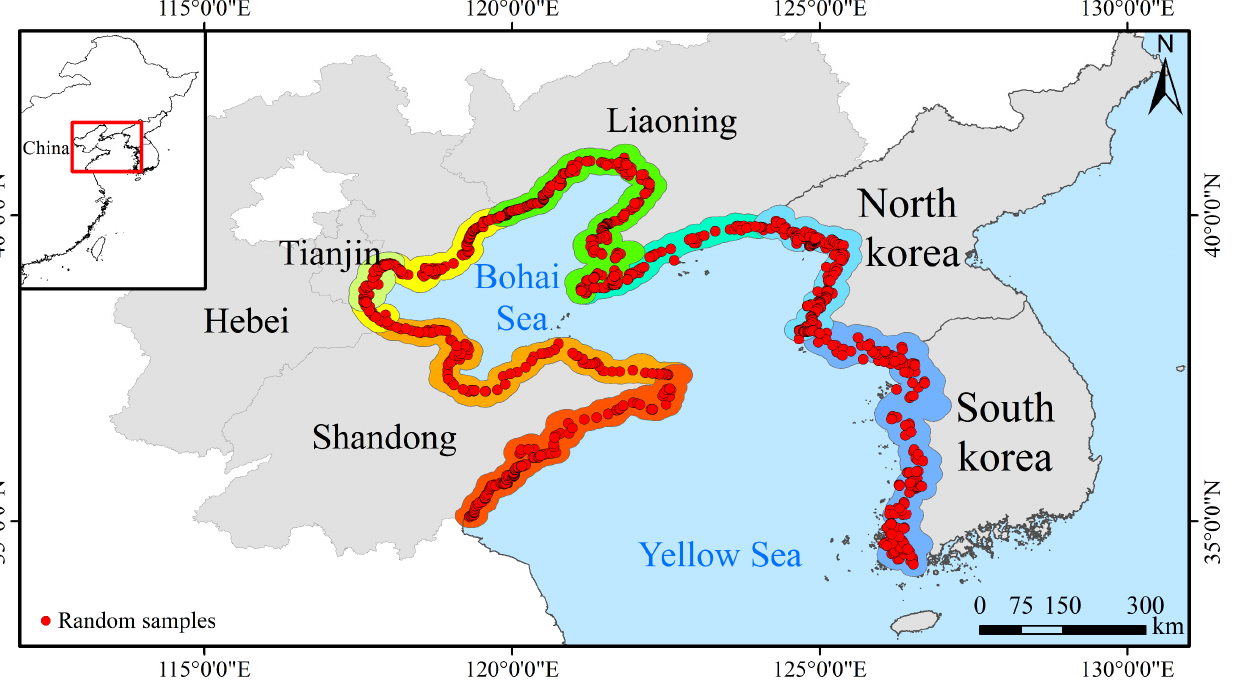
Figure 3. Random selected samples along the study area coast. The 20 km buffer along the coast with different colors displays eight sub-regions that were delineated based on geological position and administrative divisions. The top-left red circle denotes the study area on a broader